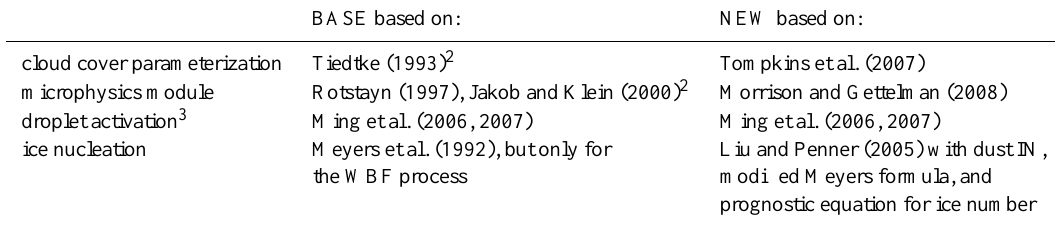
Table 1. Overview of the stratiform cloud schemes in the “BASE ” and the “NEW ” run 1 . BASE based on: NEW based on: